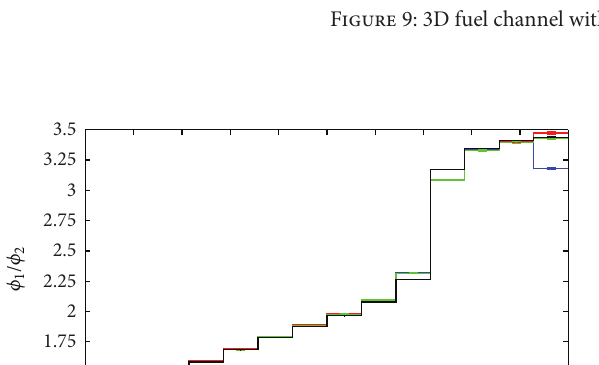
Figure 9: 3D fuel channel with axial reflector cells at both ends.